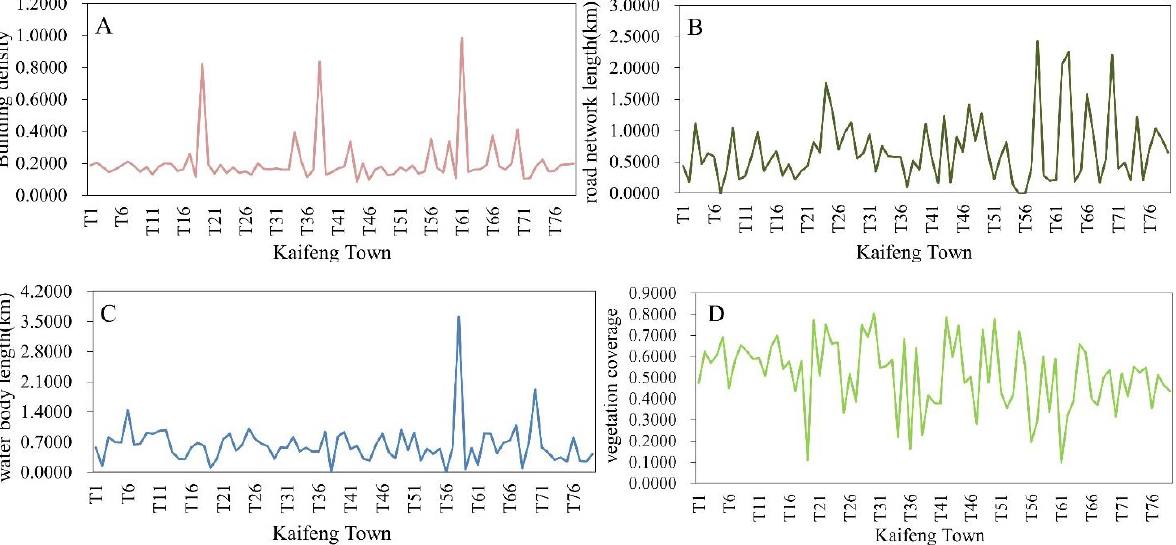
Figure 7. Line chart of each influential factor. ( A ): building density; ( B ): road network length; ( C ): water body length; ( D ): vegetation coverage.